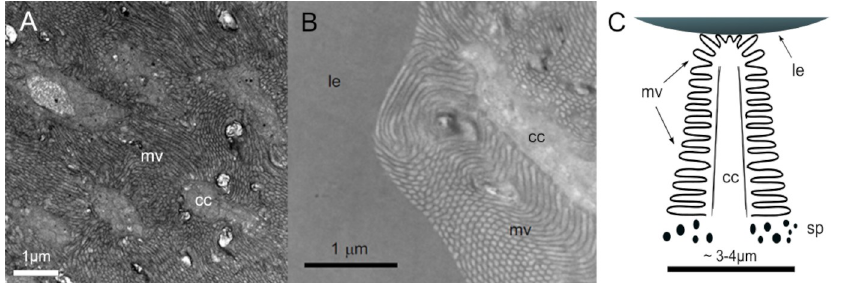
Fig 2. Photoreceptor ultrastructure. (A) Transmission electron microscopy (TEM) image of cross sectioned photoreceptors with their cytoplasmic central cores (cc) separated by microvilli (mv). (B) TEM image of a section cut along the photoreceptor abutting the lens (le). The core extends from the back of the retina towards the lens. Microvilli protrude perpendicular from the core but often bend significantly and interdigitate with those of neighbouring receptors. (C) Schematic drawing of the structure of a photoreceptor showing its cone-like shape and the basal position of the screening pigment layer (sp).